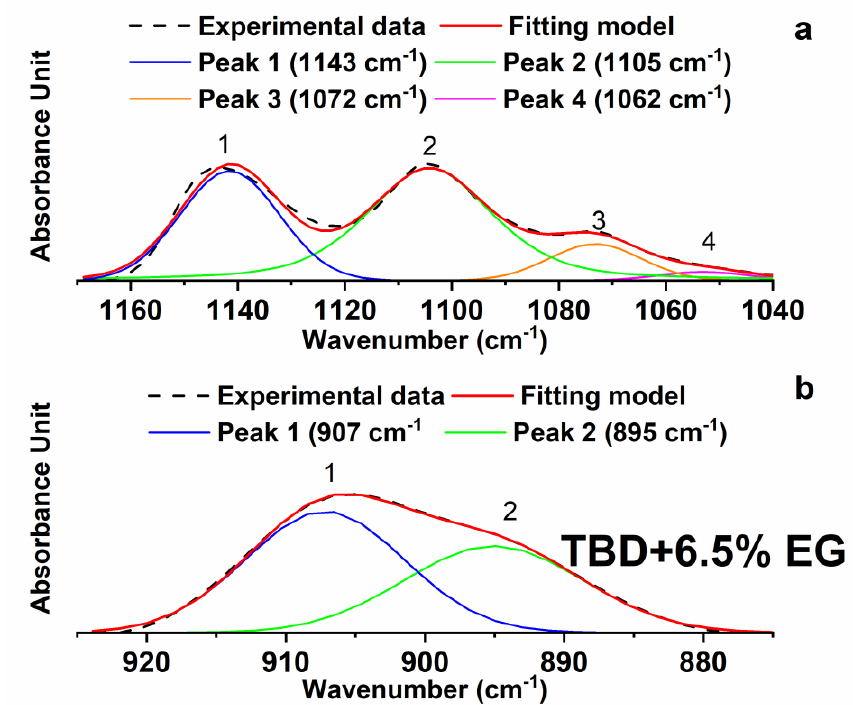
Figure 7. Deconvolution of the FTIR spectrum of the sample TBD + 6.5 %EG collected in the region of the epoxy group ( b ) and the SO 2 stretching signals ( a ). Table 2. Ratios between the areas and the intensities of the peaks at 907 cm − 1 and 1105 cm − 1 for samples containing di ff erent percentages of EG nanoparticles.